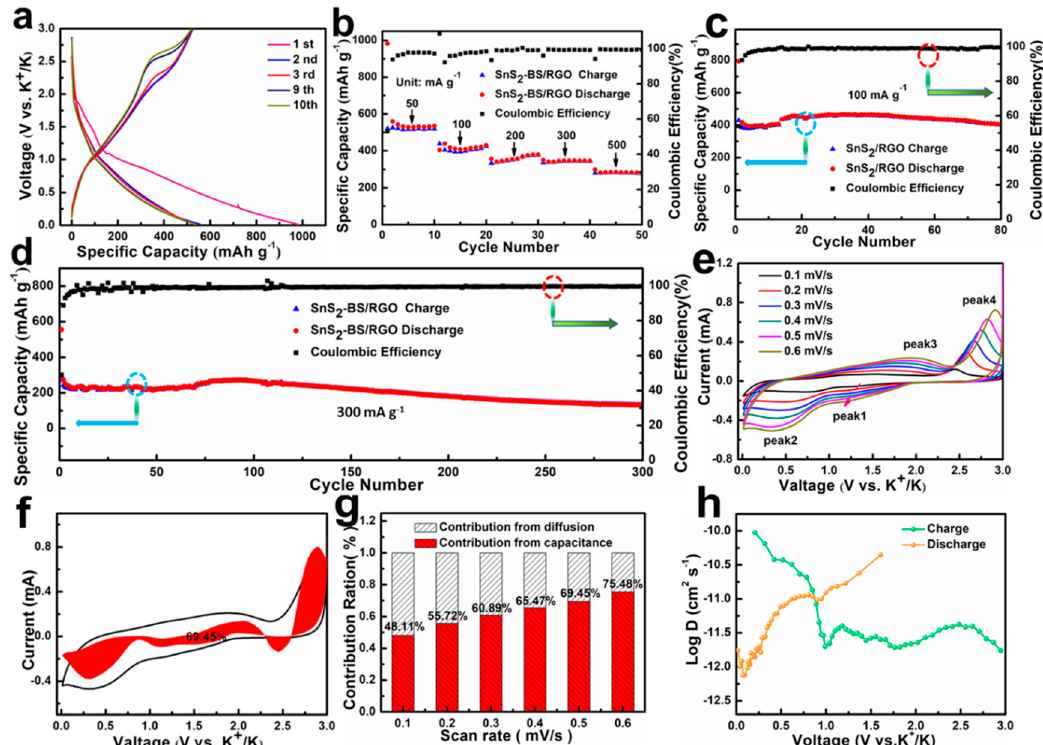
Figure 6. ( a ) Discharge/charge profiles of SnS 2 /RGO at 50 mA g − 1 in the potential range of 0.01–3.0 V vs. K/K + . ( b ) Rate capability of SnS 2 /RGO. ( c , d ) Cycling performance of SnS 2 /RGO at 100 mA g − 1 and 300 mA g − 1 , respectively. ( e – g ) The kinetics and quantitative analysis of the K + storage behavior for SnS 2 /RGO anodes. ( h ) Calculated diffusion coefficients during charging and discharging from SnS 2 /RGO.